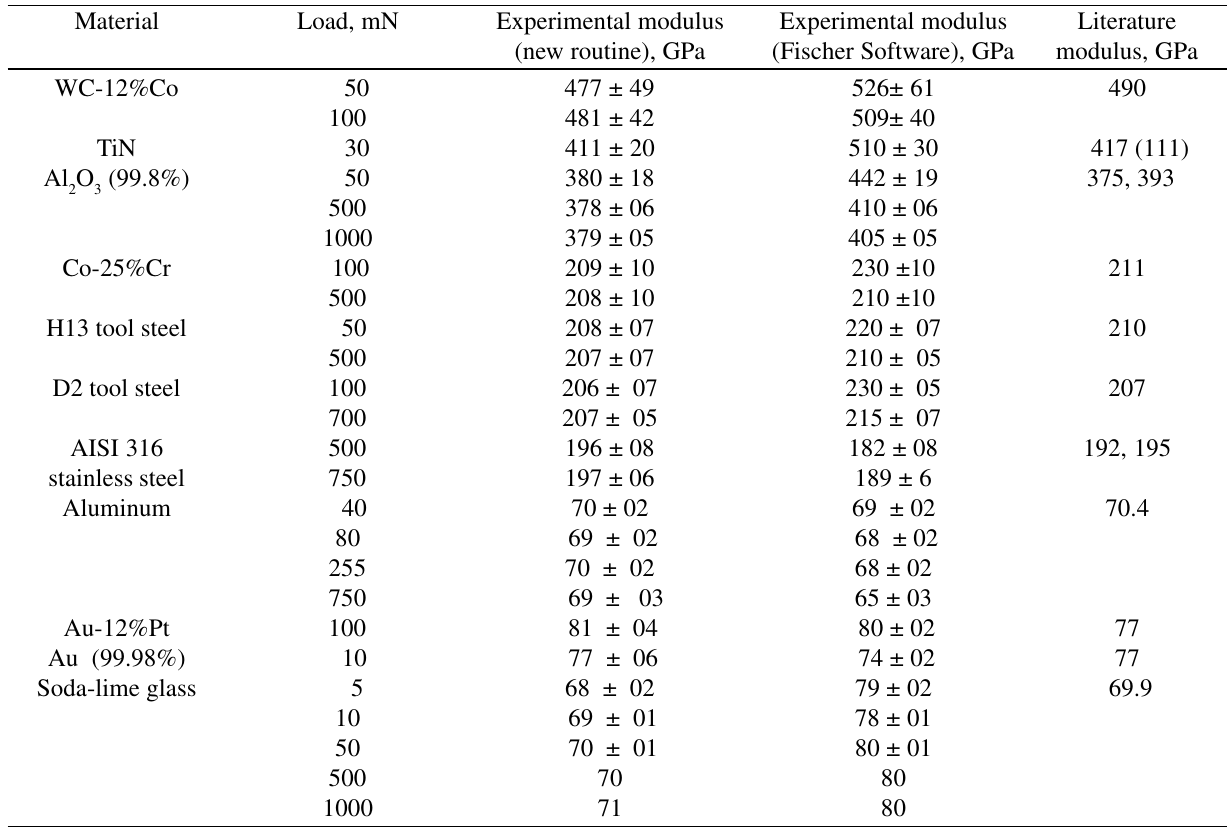
Table 3. Comparison of elastic moduli measured by means of the analysis procedure based on Oliver Pharr method with those given by Fischerscope machine. Each measurement corresponds to the average of twenty